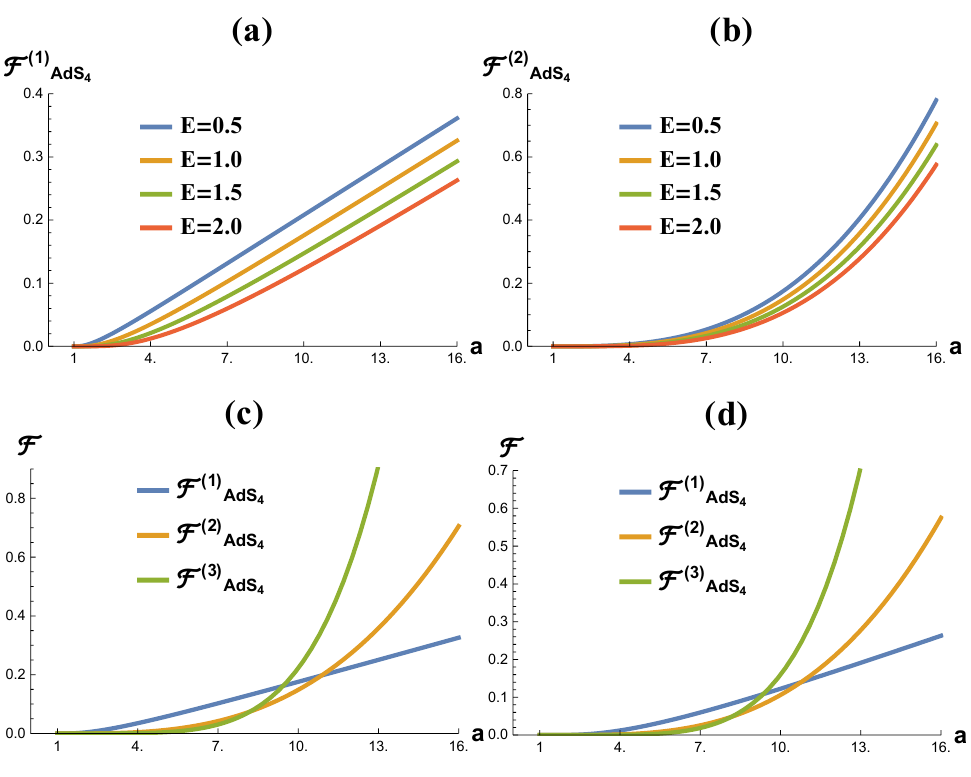
and (b) F (2) as a function of AdS 4 AdS 4 , F (2) and F (3) for (c) AdS 4 AdS 4 AdS 4